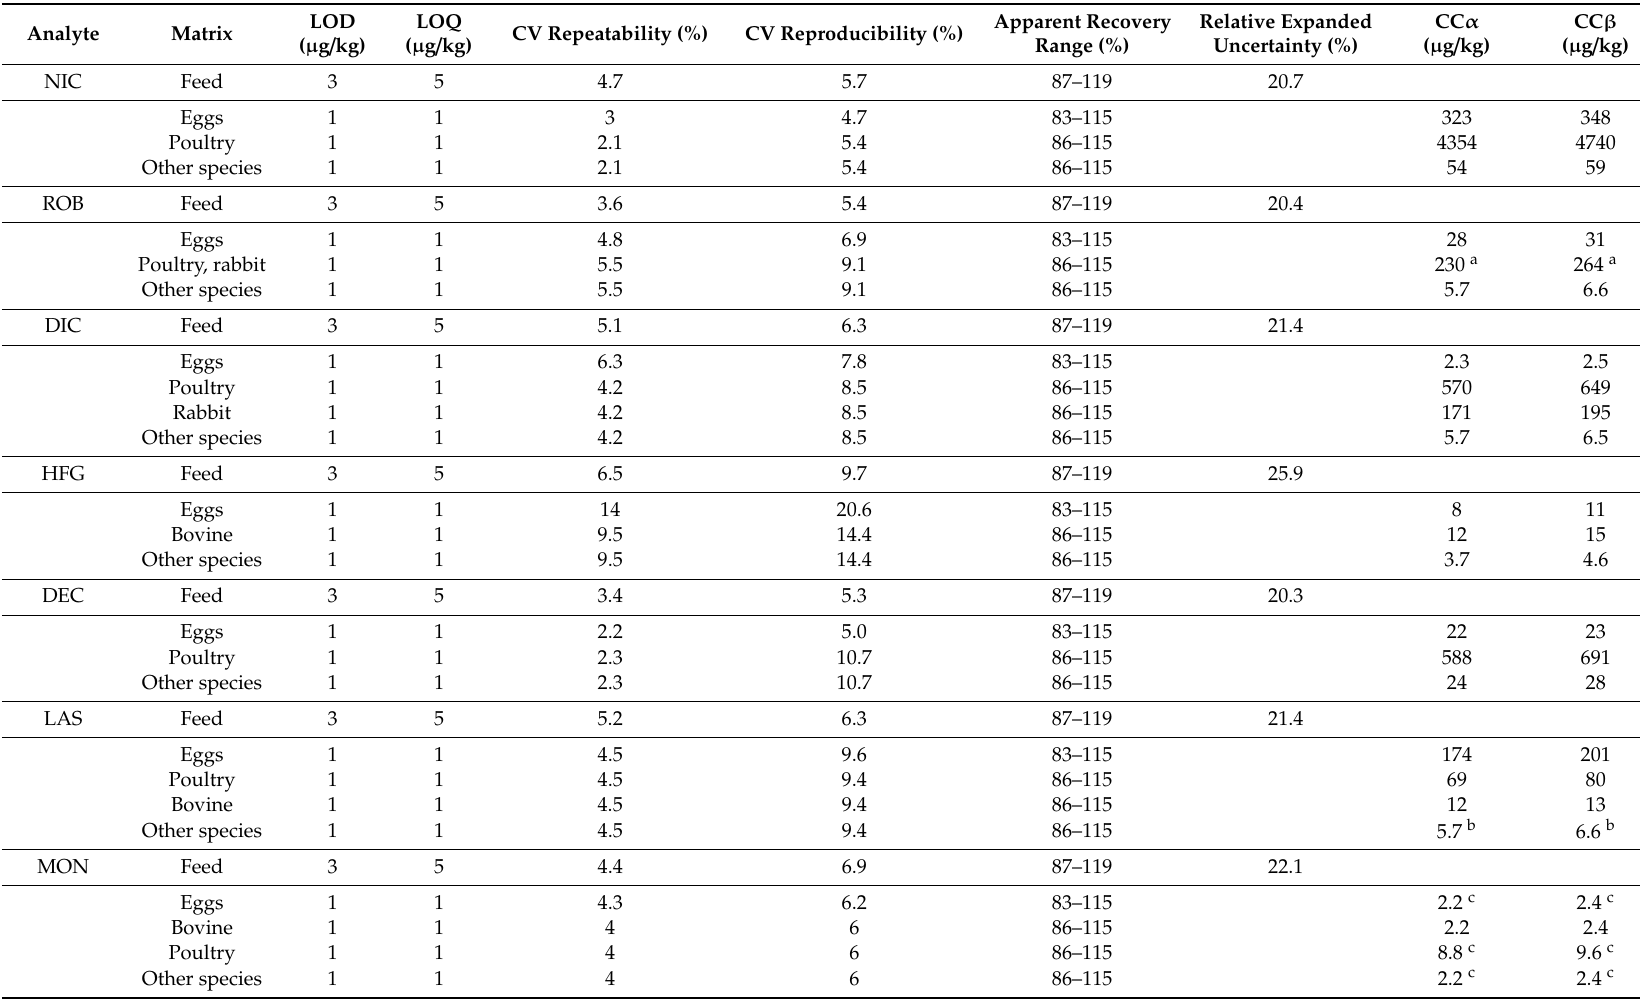
Table 1. Validation parameters for the methods used in the determination of coccidiostats in feed, muscle and eggs for residue control in Italy.